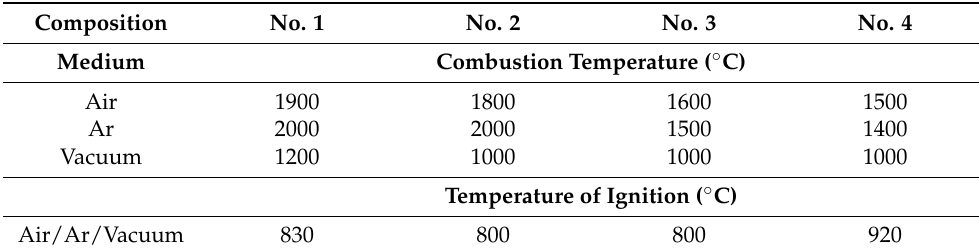
Table 4. Combustion rate in the W/PTFE/Al